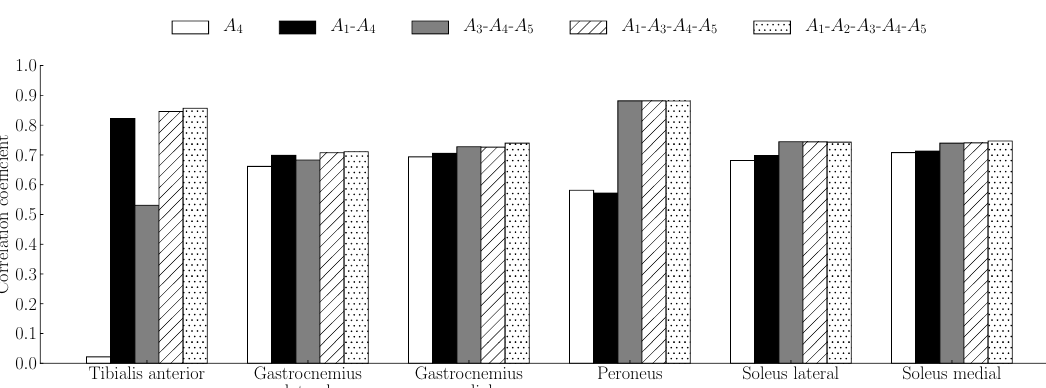
Figure 3. Correlation coefficients between the measured signals and the estimated signals. Five combinations whose median value of correlation coefficients was the highest in each number of sensors. The correlation coefficients of [ A 1 - A 2 - A 3 - A 4 - A 5 ] combination was the highest from those of other combinations in all muscles.